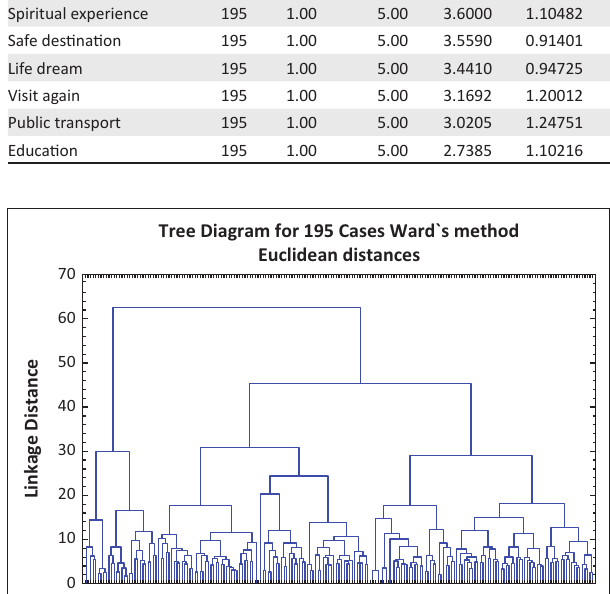
FIGURE 1: Four cluster solution: Ward’s method with squared Euclidean distance